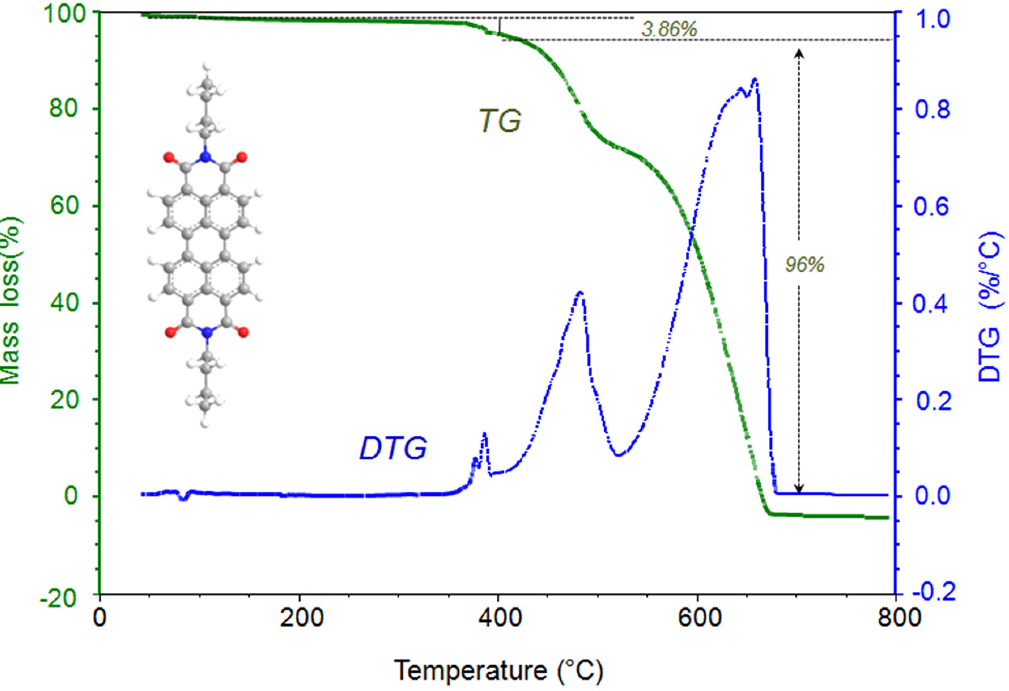
Figure 1. TG and DTG curves for BuPTCD powder from 25 o C to 800 o C (heating rate of 10 o C/min). Inset: BuPTCD molecular structure.